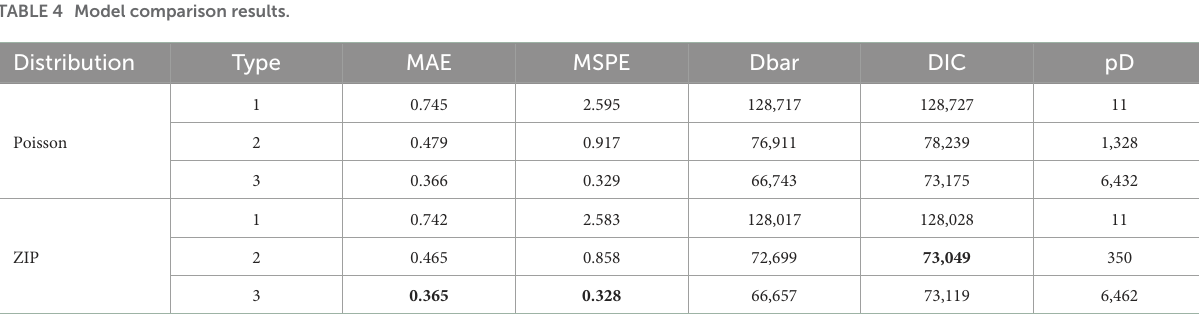
TABLE 4 Model comparison